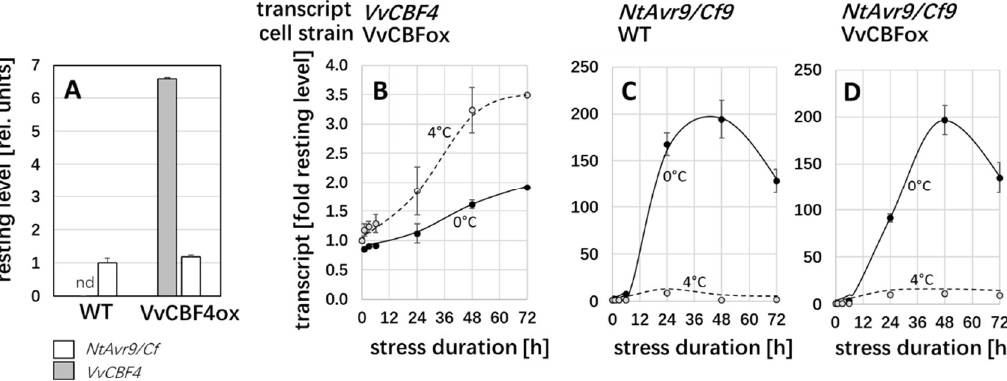
Figure 3. Regulation of transcripts for VvCBF4 and its tobacco homologue NtAvr9/Cf9 in response to chilling (4 °C) and freezing (0 °C) depending on cell strain. ( A ) The resting levels for the transcripts of the two CBF4 homologues in the absence of cold stress in non-transformed BY-2 cells (WT) versus cells constitutively overexpressing VvCBF4 in fusion with GFP (VvCBF4ox). nd, non-detectable. ( A – C ) Time course for steady-state transcript levels for VvCBF4 ( B ) and native NtAvr9/Cf9 ( C , D ) during chilling and freezing in the background of the non-transformed WT ( C ) or cells overexpressing VvCBF4 ( B , D ). Data are expressed relative to the resting levels (given in ( A )) and represent means ± SE from three independent experimental series, each in technical triplicates.